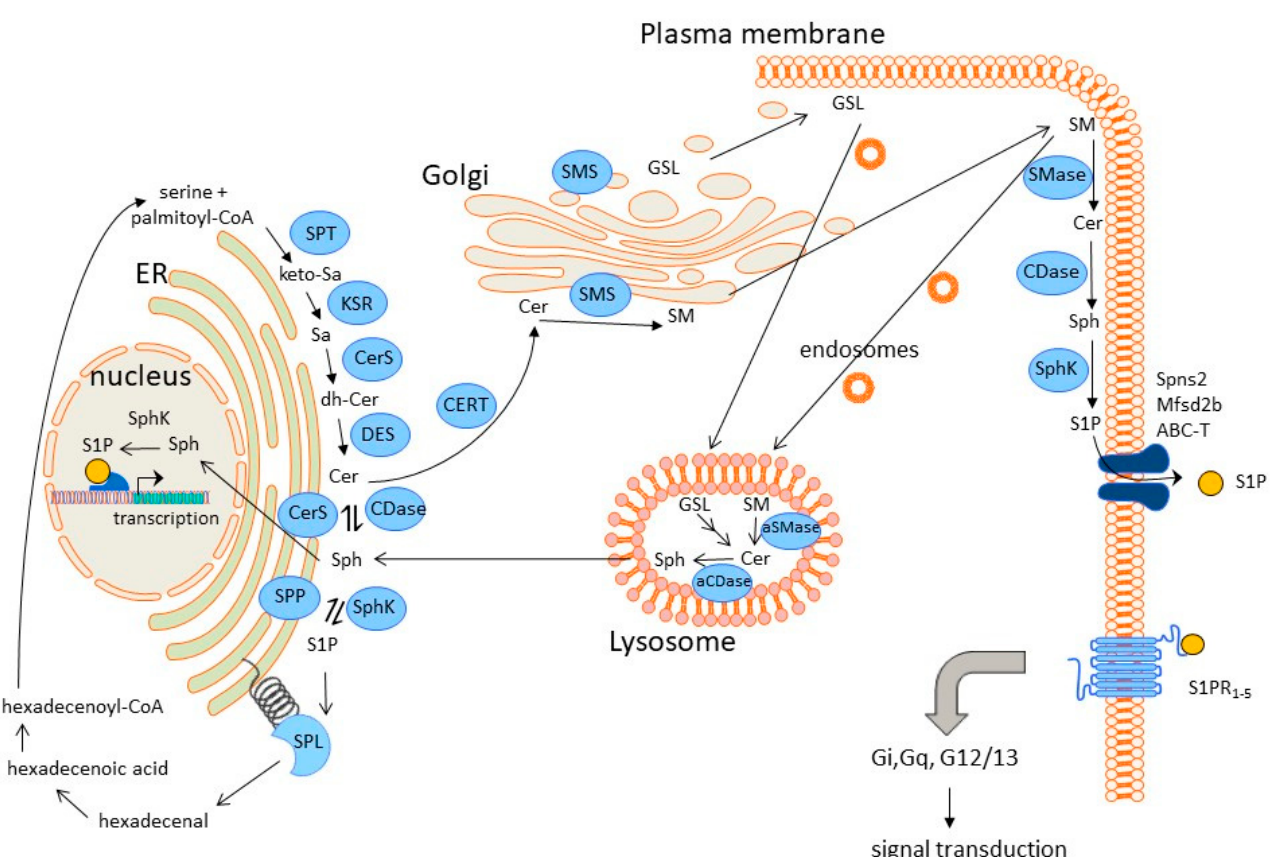
Figure 2. Subcellular pools of sphingolipids and their biosynthesis and degradation routes.